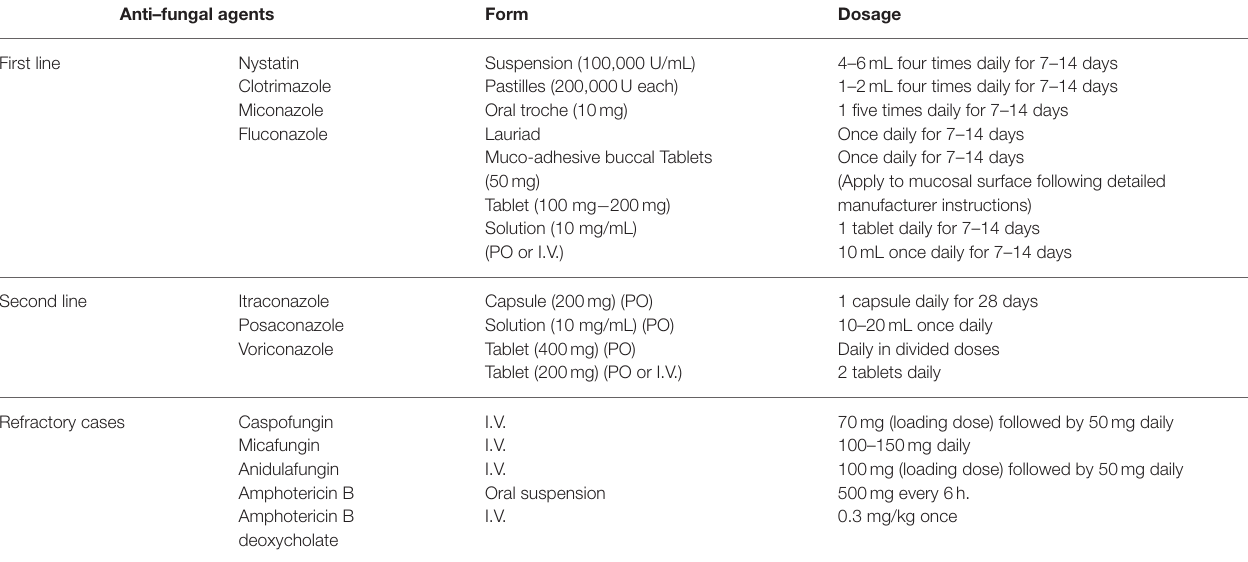
TABLE 4 | Treatment of OPC (Vazquez, 2010; Lortholary et al., 2012; Patil et al.,